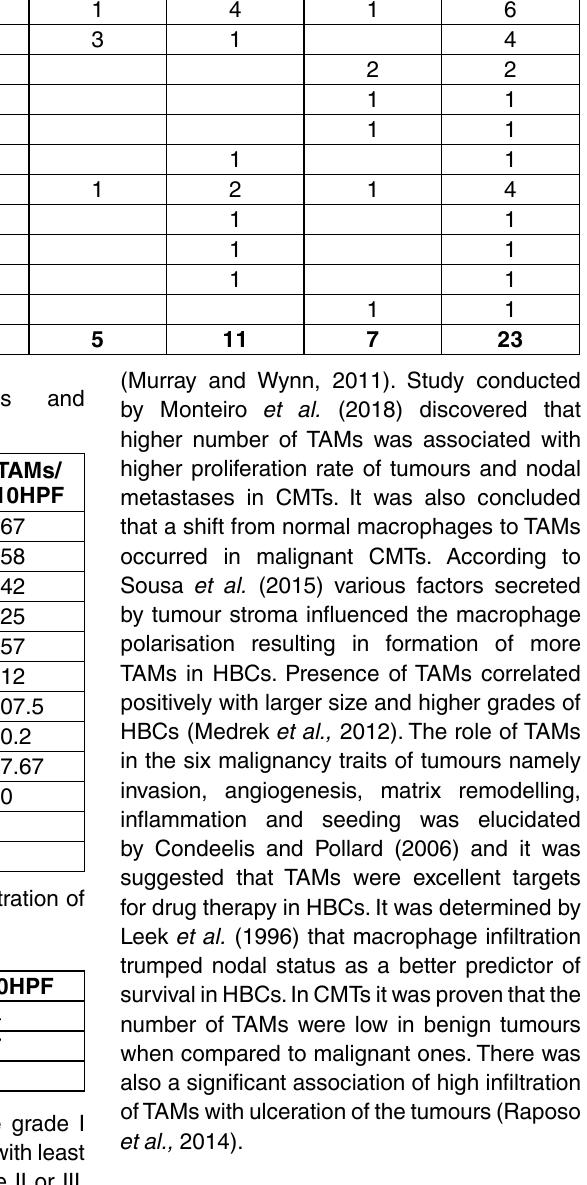
table 1. Histopathological subtypes and their respective histological malignancy grading tumour subtype Grade